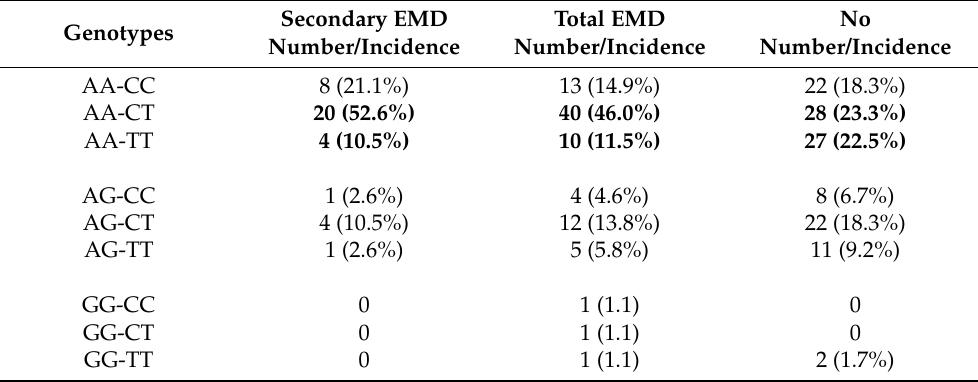
Table 7. Examination of the interaction between HPSE2 gene SNPs rs658225 and rs754585 in correla- tion with secondary extramedullary disease (EMD) of multiple